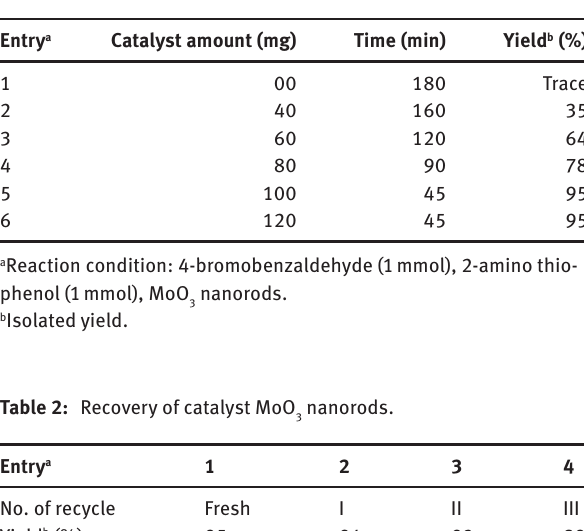
Table 3: Synthesis of 2-aryl benzothiazole derivative using MoO nanorods.